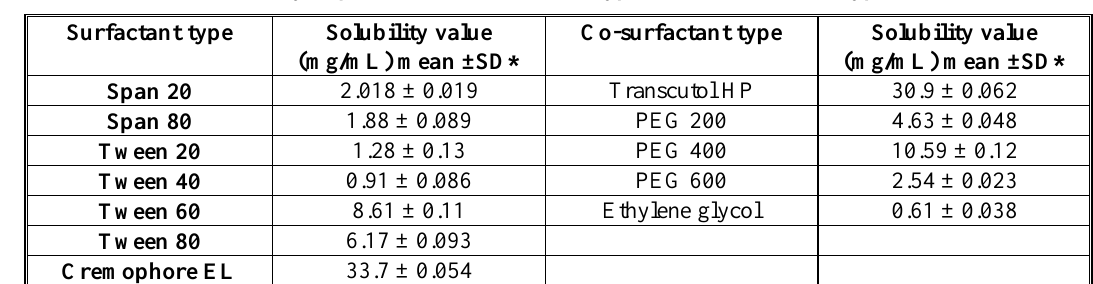
Table 4. Saturation solubility of piroxicam in surfactant type and co-surfactant